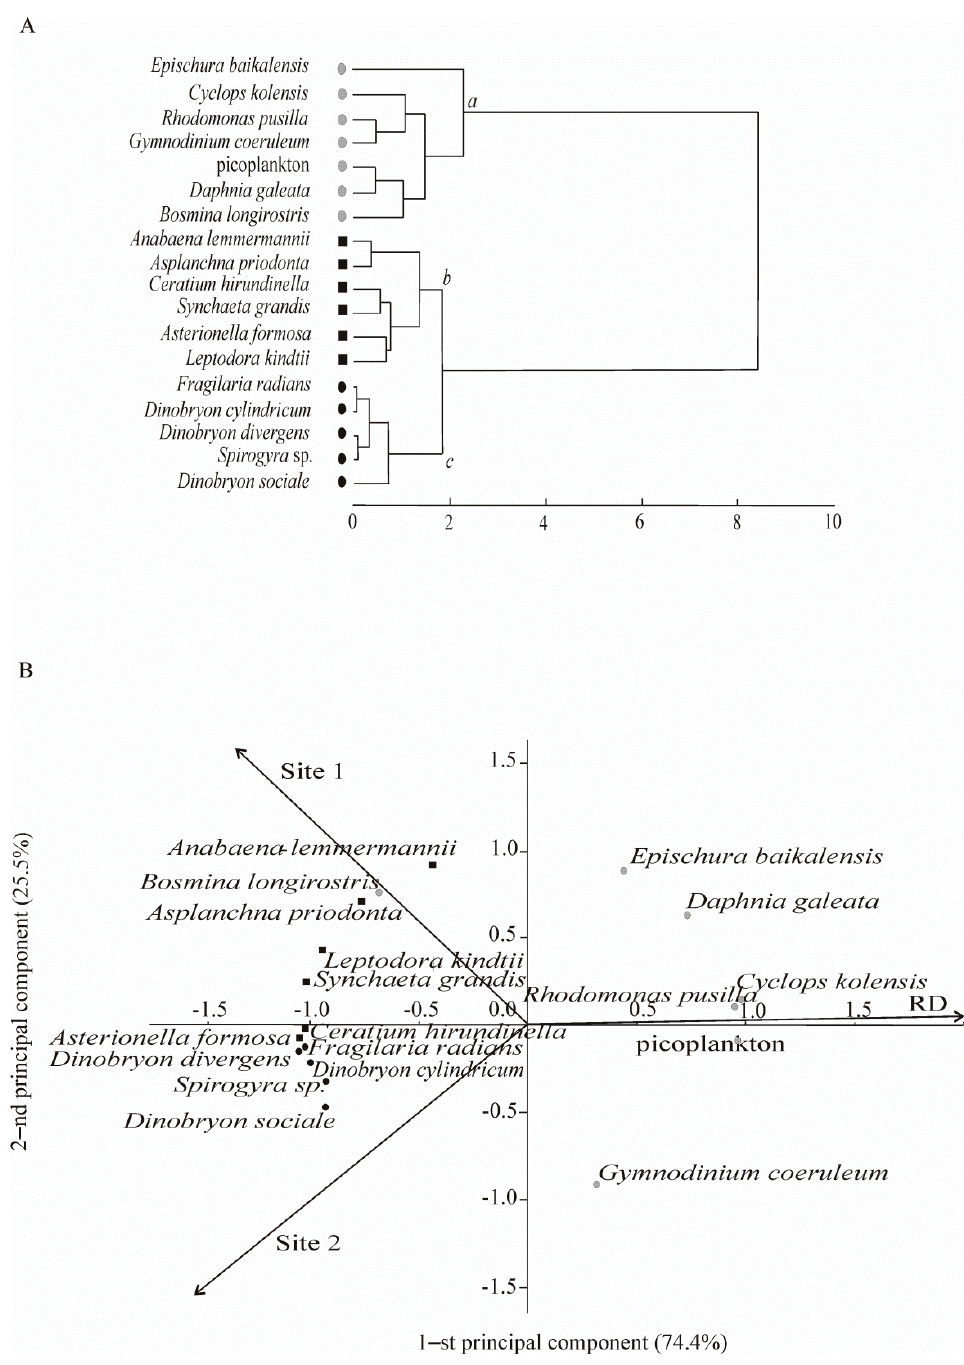
Figure 2. Plankton community structure and spatial distribution of dominant species in the coastal zone of Lake Baikal. ( A ) Species composition of plankton communities ( a , b , and c ) extracted by Ward’s cluster analysis using Euclidean distances. ( B ) Locations of the identified plankton communities in the plane of the first two principal components (PCA). RD—reference data, including samples collected in the southern basin of Lake Baikal in the past century; Site 1 included stations I, II, and III of the background area in 2016; Site 2 included stations IV, V, and VI of the area with human activity in 2016 (see Figure 1D).